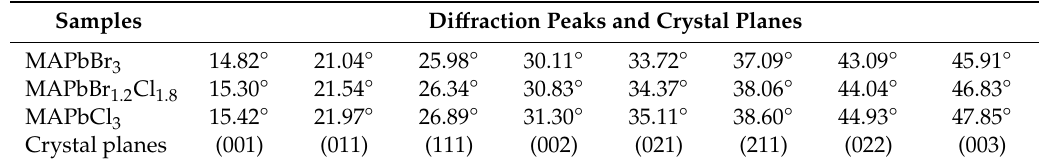
Table 1. XRD di ff raction peaks and corresponding crystal planes of PVDF-MAPbBr 3 − x Cl x membranes. Samples Di ff raction Peaks and Crystal